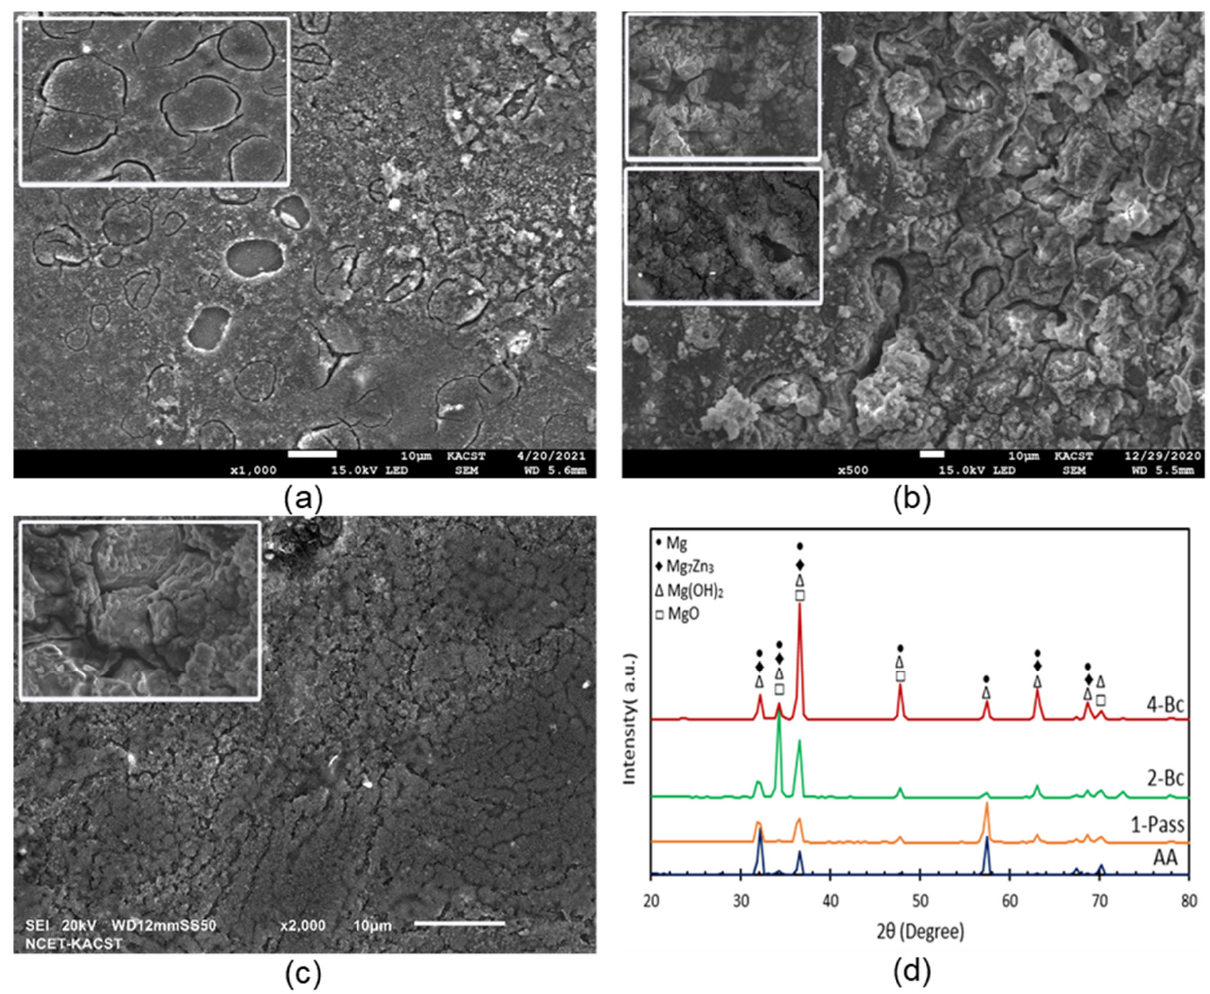
Figure 14. ( a – c ) SEM micrographs of the ZK30 alloy after corrosion test for ( a ) AA, ( b ) 1-P, ( c ) 4-Bc and ( d ) X-ray diffraction patterns of ZK30 alloy after corrosion .